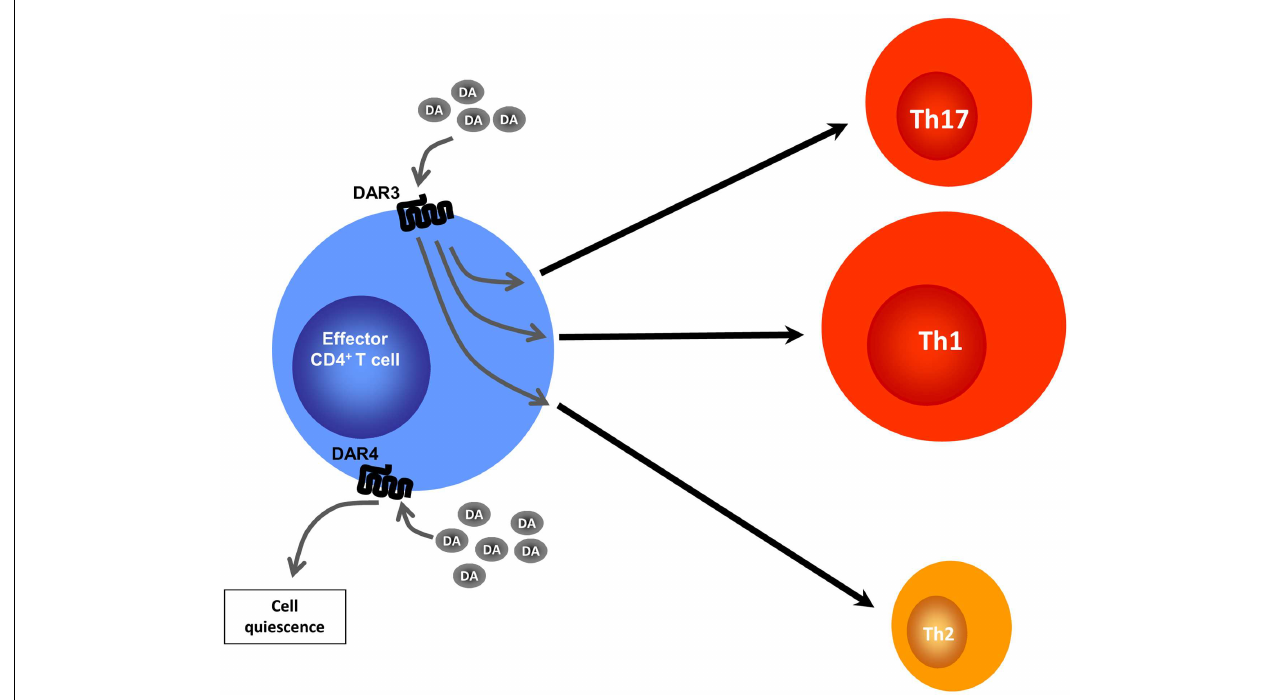
expression of KLF2, a transcription factor that regulatesT cell quiescence. At lower DA concentrations, stimulation of DAR3 expressed on DCs results, by means of an undefined mechanism, in heightenedTh1 responses along with a reduction inTh17 immunity and a reduction of Th2-related